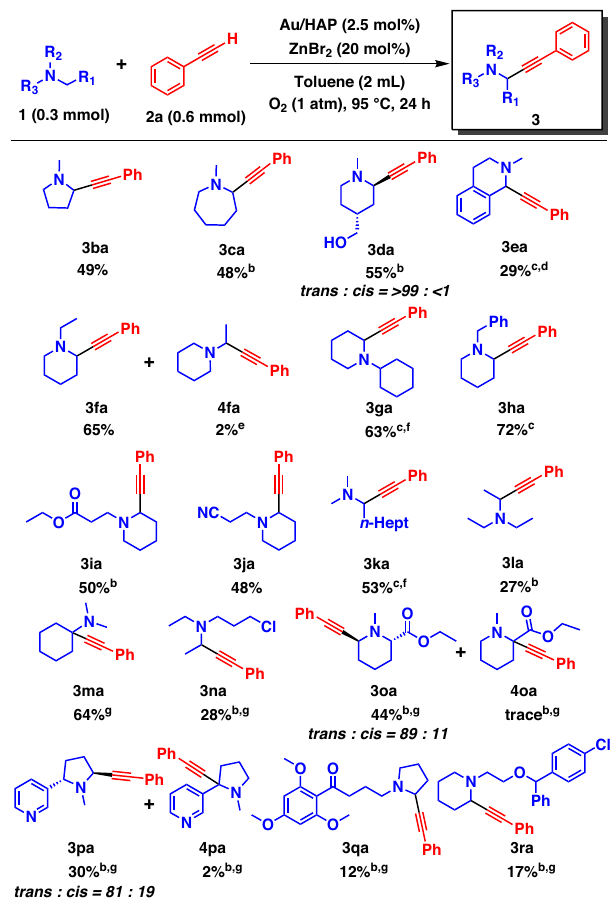
Fig. 3 | Tertiary amine substrate scope of the combined catalytic system comprising Au/HAP and Zn species. aa Reaction conditions: 1 (0.3mmol), 2a (0.6mmol), Au/HAP (100mg, Au: 2.5mol%), ZnBr 2 (13mg, 20mol%), toluene (2mL),95°C,O 2 (1atm),24h.Isolatedyieldsareshown. b Au/HAP(160mg,4mol%). c 1 (1mmol), 2a (0.5mmol), ZnBr 2 (11mg, 10mol%). d PhCF 3 (2mL). e GC yield. f Au/ HAP (200mg). g 2a (1.8mmol), MS-4A (300mg). The ratios of cis / trans -isomers were determined by 1 H NMR analysis or isolated yields. HAP